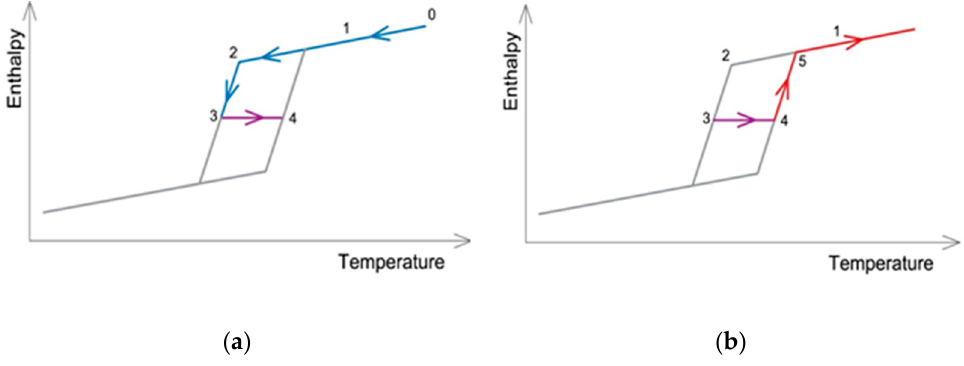
Figure 1. Phase change hysteresis process represented as a function of temperature.